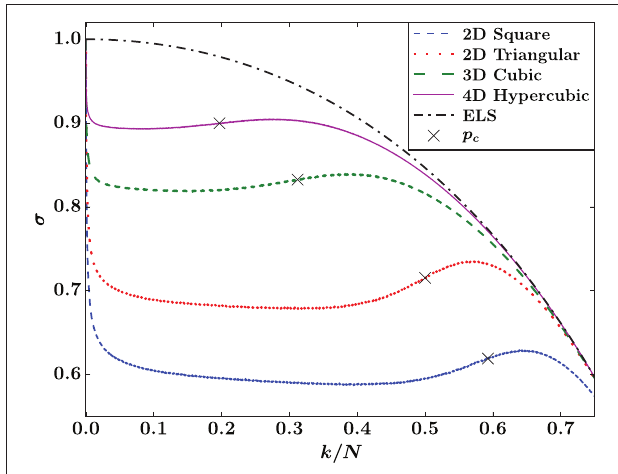
FIGURE 7 | Sample averaged LLS load curves on lattices in two to four dimensions with corresponding site percolation thresholds p c marked. The threshold distribution is P ( x ) = 1 − exp ( 1 − x ) , Equation (4) with β = t 0 = 1.